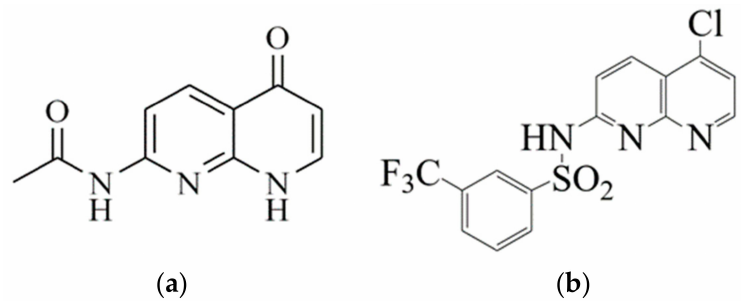
Figure 3. Chemical structures of the 1,8-naphthyridine derivatives: ( a ) 7-acetamido-1,8-naphthyridin-4(1H)- one (1,8-NA); ( b ) 3-trifluoromethyl-N-(5-chloro-1,8-naphthyridin-2-yl)-benzenesulfonamide (3-TNB).